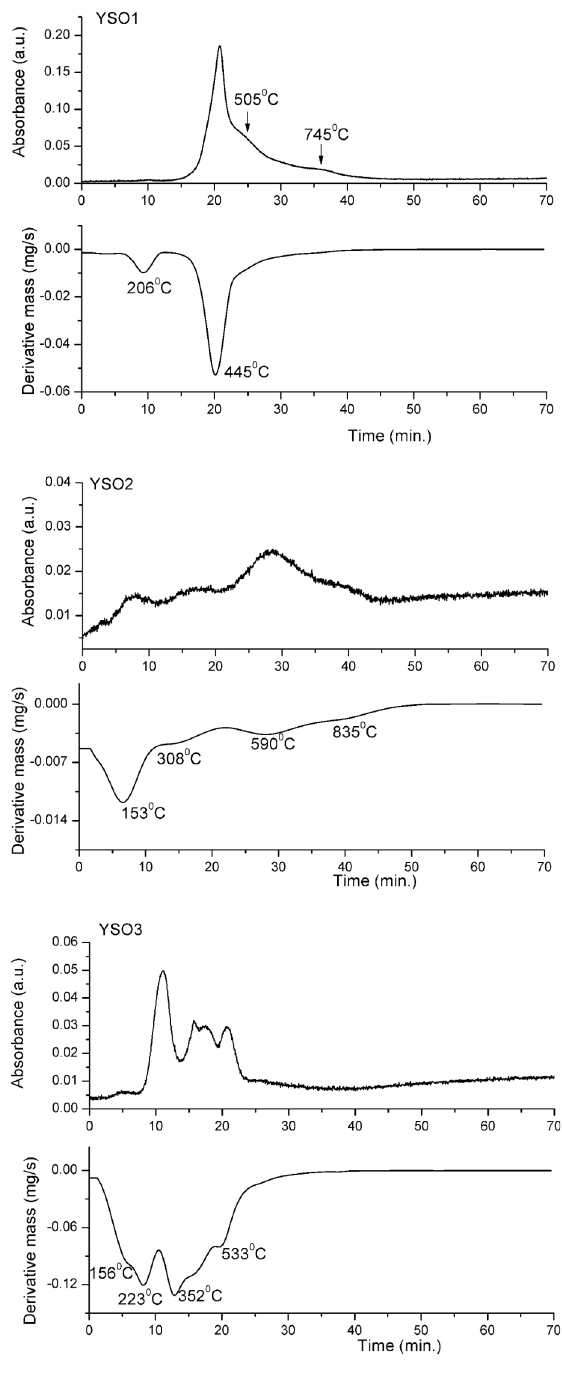
Figure 4. Gram Schmidt diagram coupled with DTG curves of